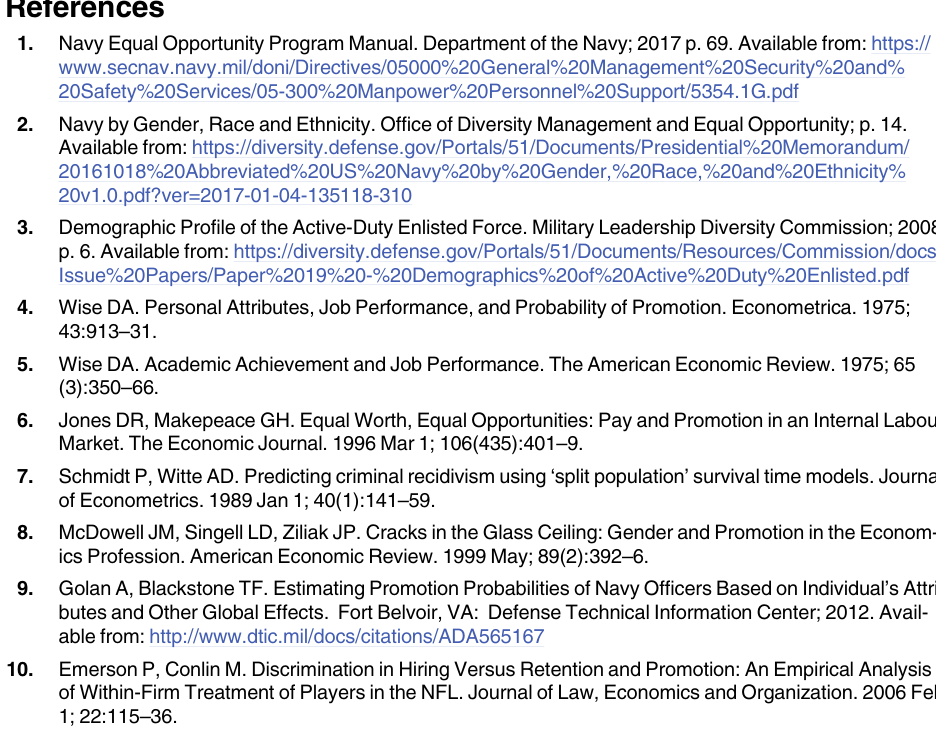
S1 Fig. Relative promotion and ‘not promoted but stayed’ (E5 to E6) frequencies of Blacks, Hispanics, and females for three different Navy skill